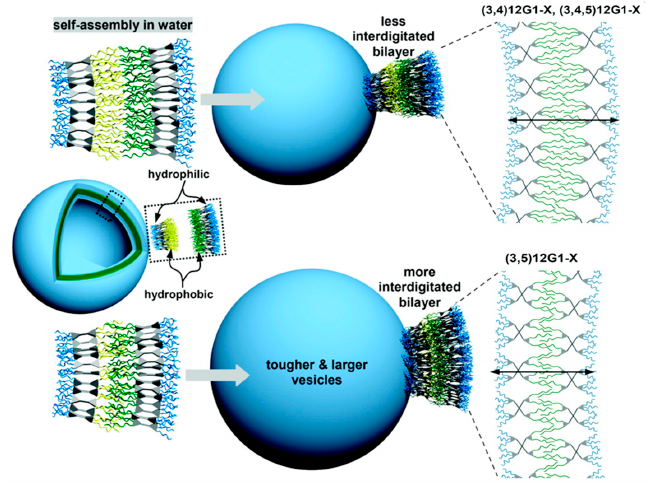
Figure 10. Correlation between substitution pattern of the hydrophobic part of hydrogenated JDs, its interdigitation in the bilayers and the vesicular membrane thickness, curvature and size. Copyright American Chemical Society, adapted from Journal of the American Chemical Society 2011 [77].